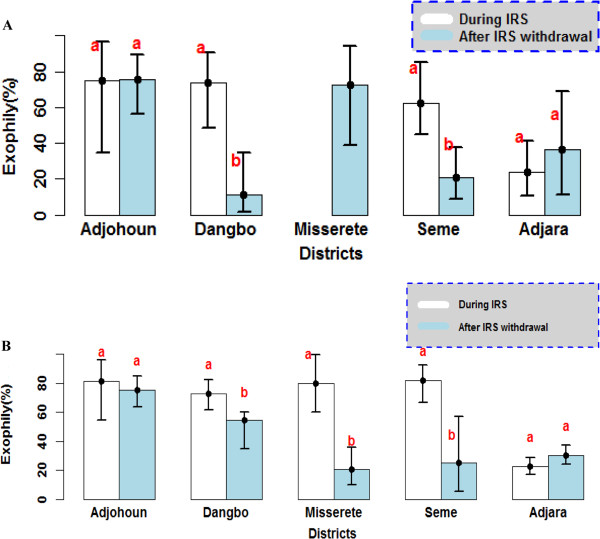
Exophily rate of An. gambiae observed during IRS campaign and after IRS withdrawal in central area (A) and peripheral area (B) in the various districts. Exophily rate carrying the same letter per district was not significantly different (p> 0.05).